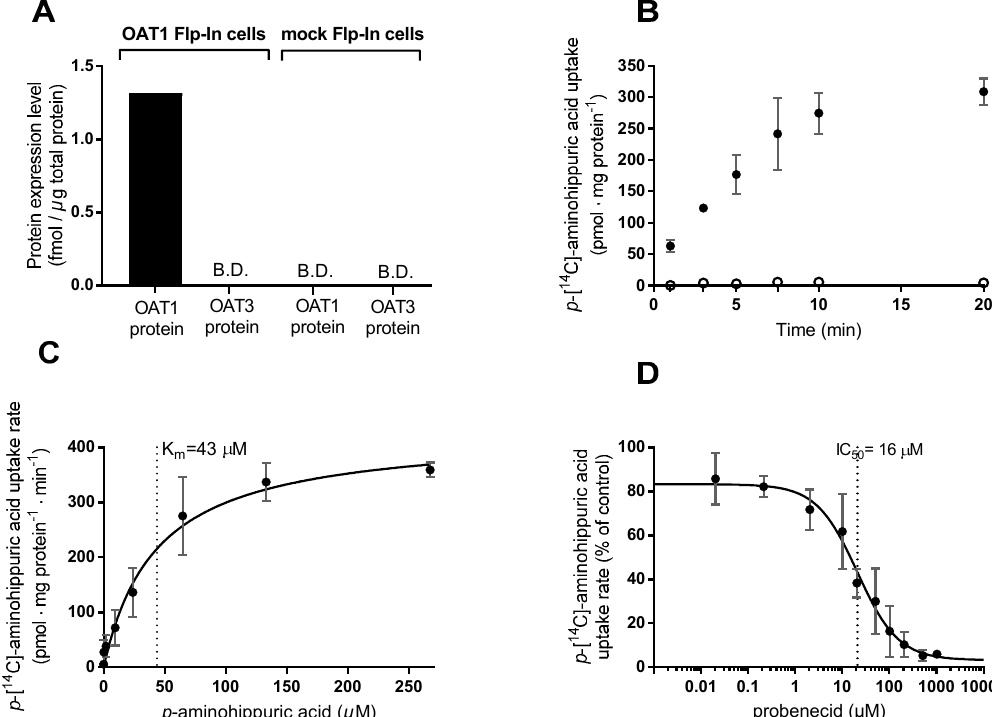
Figure 2. Functional characterization of HEK293-Flp-In cell lines stably transfected with SLC22A6 ( OAT1 ) or empty vector (mock-transfected). ( A ) OAT1 and OAT3 protein expression levels in HEK293-Flp-In OAT1 cells and HEK293-Flp-In mock cells. B.D., below the detection limit. ( B ) Time-dependent uptake of 9.5 µM p -[ 14 C]-aminohippuric acid (PAH) in HEK293-Flp-In OAT1 expressing cells (closed circles) and HEK293-Flp-In mock cells (open circles). ( C ) The OAT1-mediated uptake rate of 0–277 µM of PAH using 0.02–9.5 µM [ 14 C]-PAH in HEK293-Flp-In OAT1 cells (closed circles). ( D ) Effect of 0.02–1022 µM probenecid on the uptake rate of 9.5 µM [ 14 C]-PAH in HEK293-Flp-In OAT1 cells. Each data point represents the mean±SEM of replicates in three cell passages ( B, C, D ) or results from one cell passage ( A ) obtained at Lab. 1.